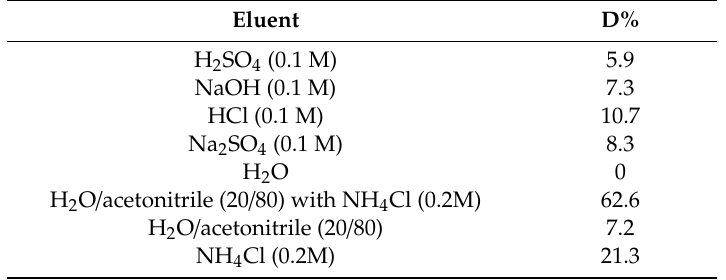
Table 2. Desorption levels (D%) of [bpy] Cl from sepiolite using di ff erent desorbing